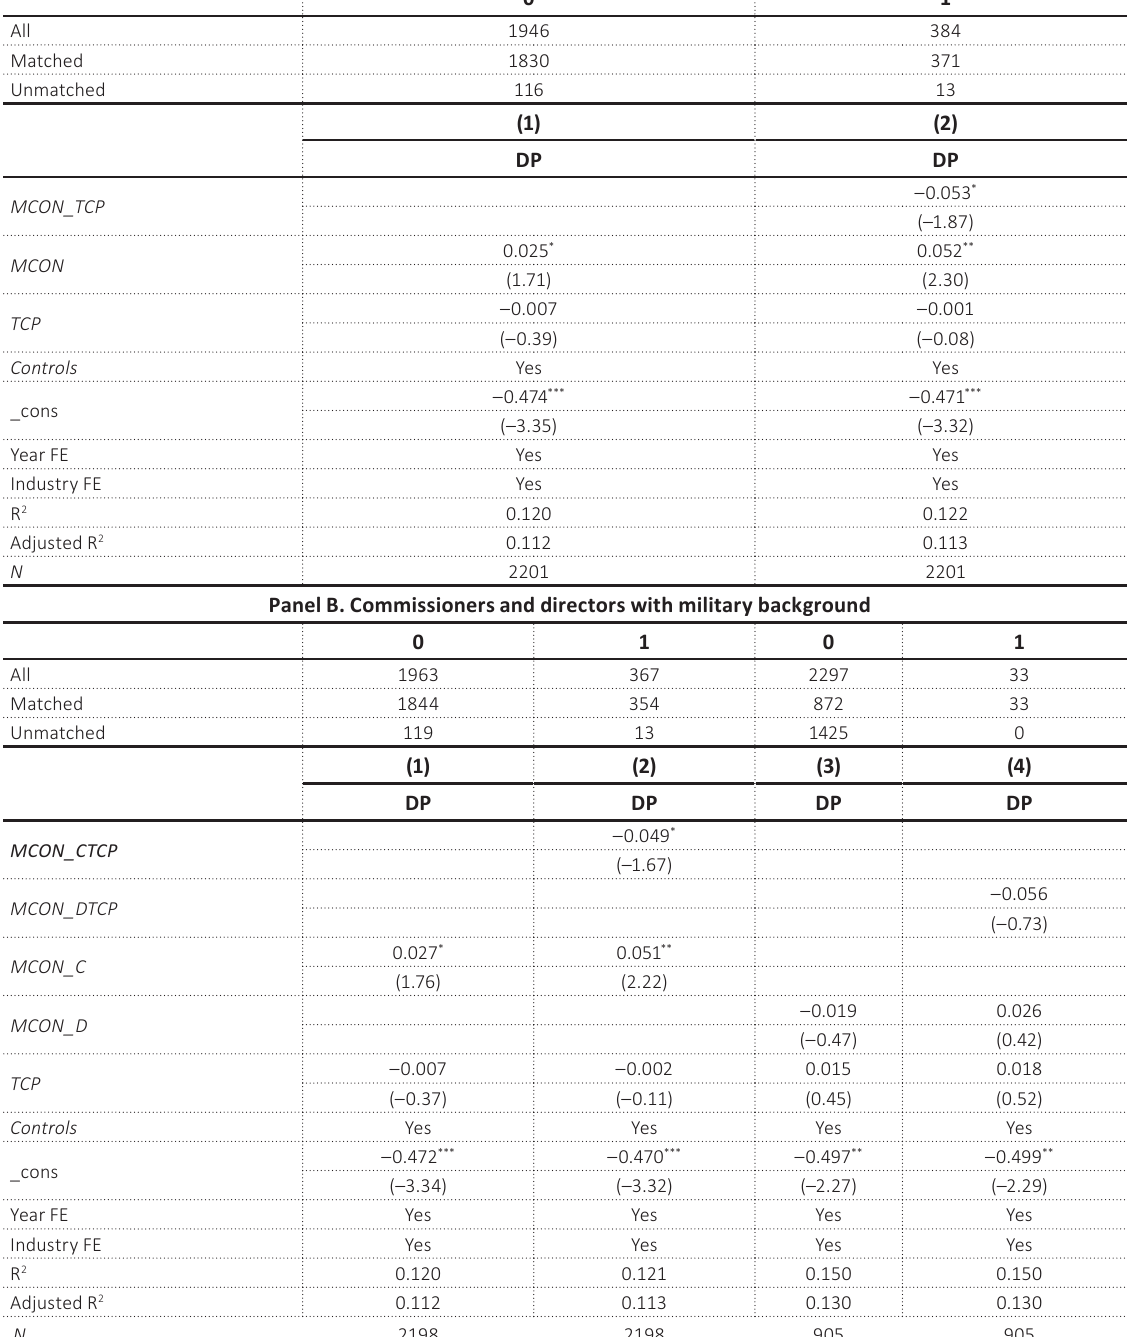
Panel A. Military-connected